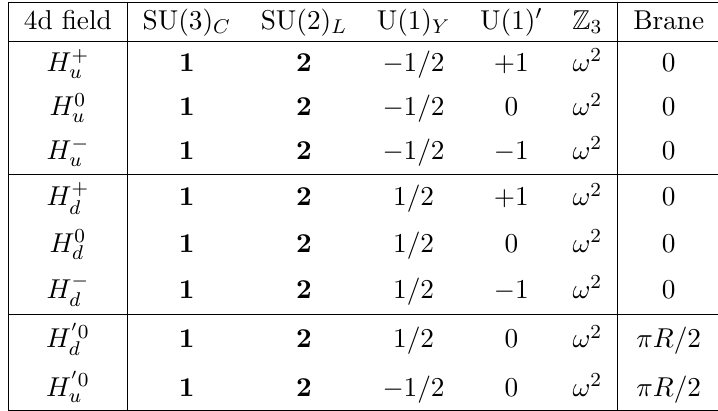
are the physical Higgses and are u,d